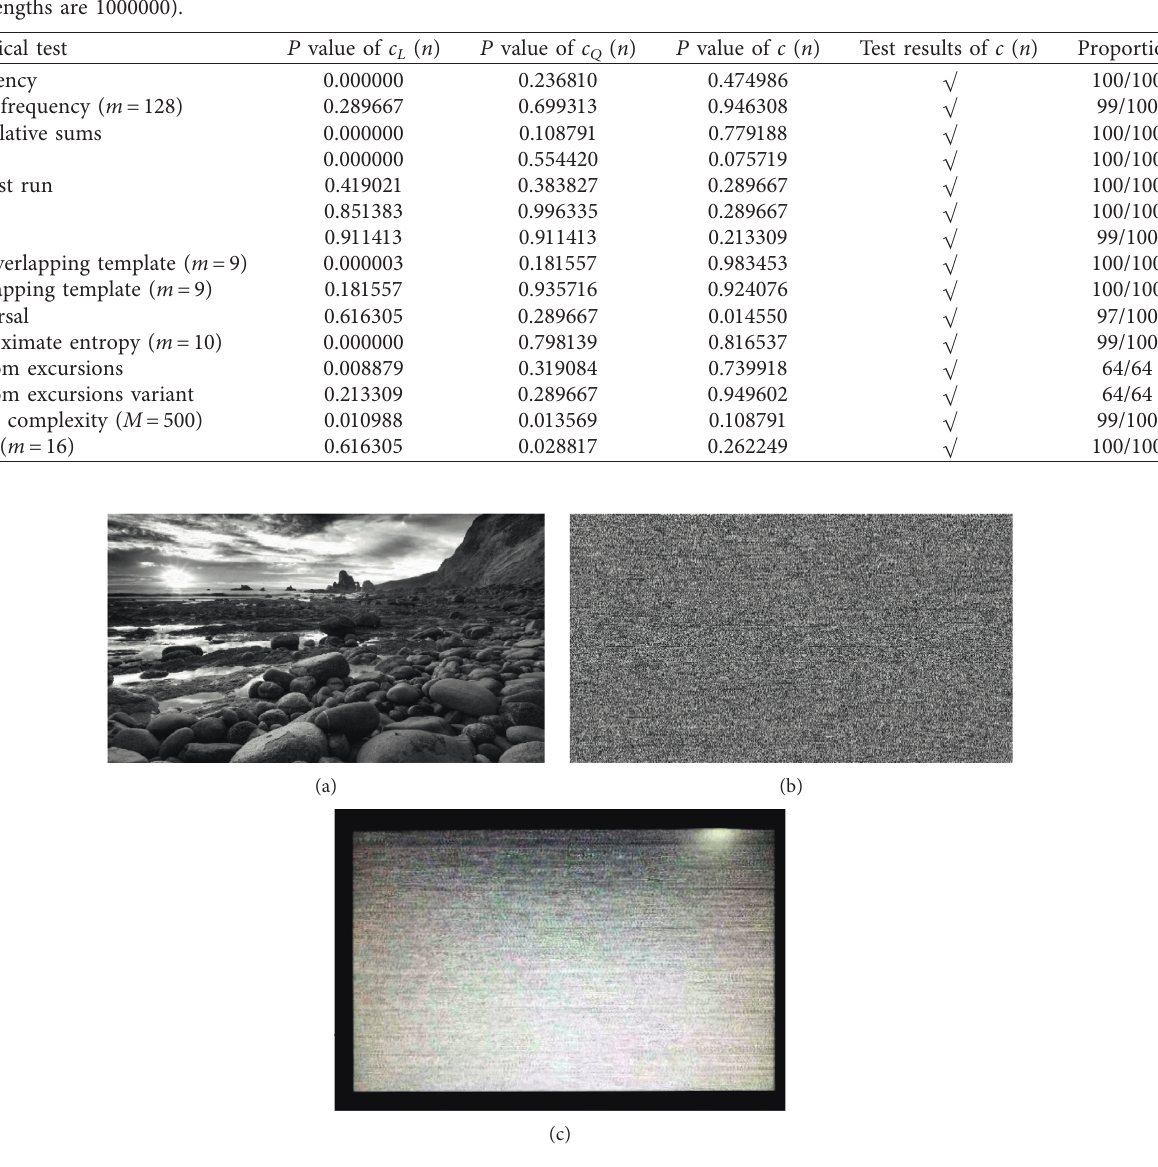
Figure 6: The original and encrypted pictures of a video and the corresponding encrypted video data through FPGA. (a) The original picture of a video. (b) The encrypted picture of a video. (c) Encrypted video data shown on a monitor.